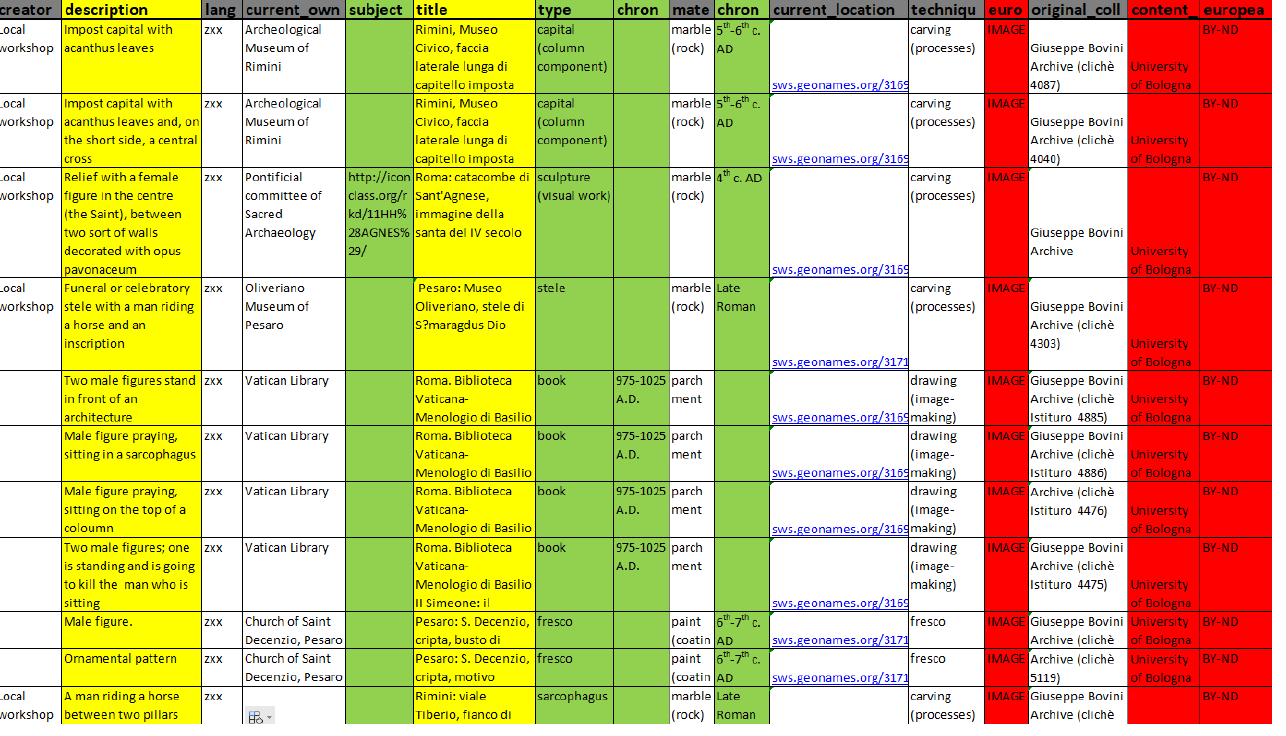
Figure 2. Sample data for xlsx importing.